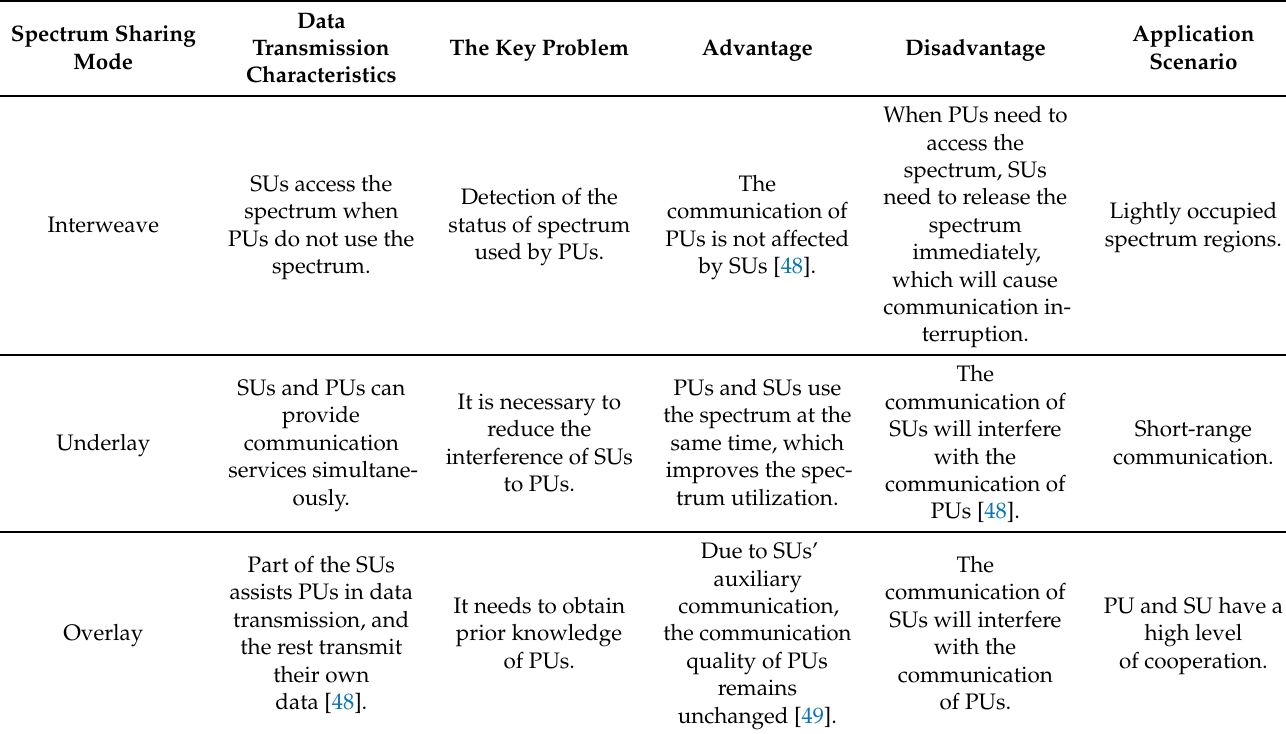
Figure 7. Classification of spectrum sharing methods Table 6. Comparison of interweave, underlay and